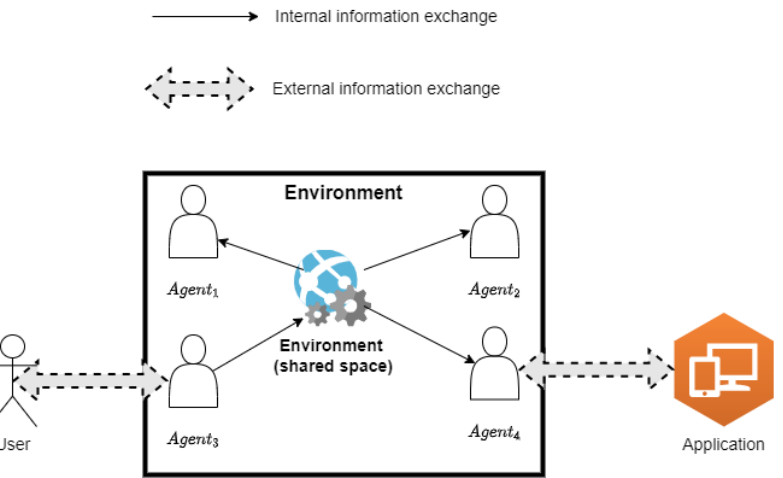
Figure 7. Architecture of a Multi-agent system with general-purpose explicit